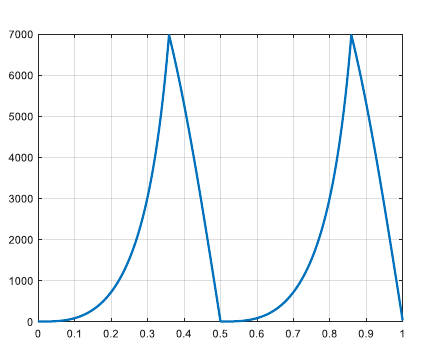
Figure 14. Tangential force of the Scotch Yoke mechanism [N].